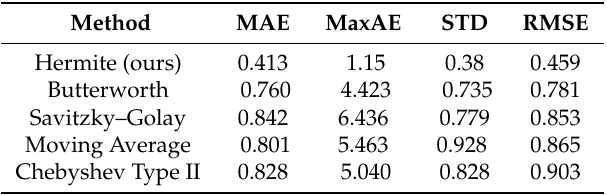
Table 1. Comparative results of our approach with other conventional denoising approaches. MAE = mean absolute error; MaxAE = maximum absolute error; STD = standard deviation of the absolute error; RMSE = root mean squared